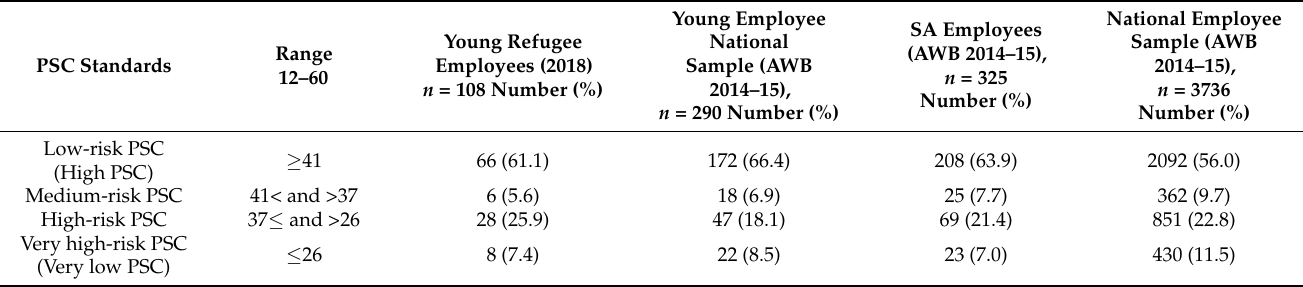
Table 4. PSC-12 Benchmark standards, classification for young refugees in comparison with AWB data (youth national, SA employees, and the total national